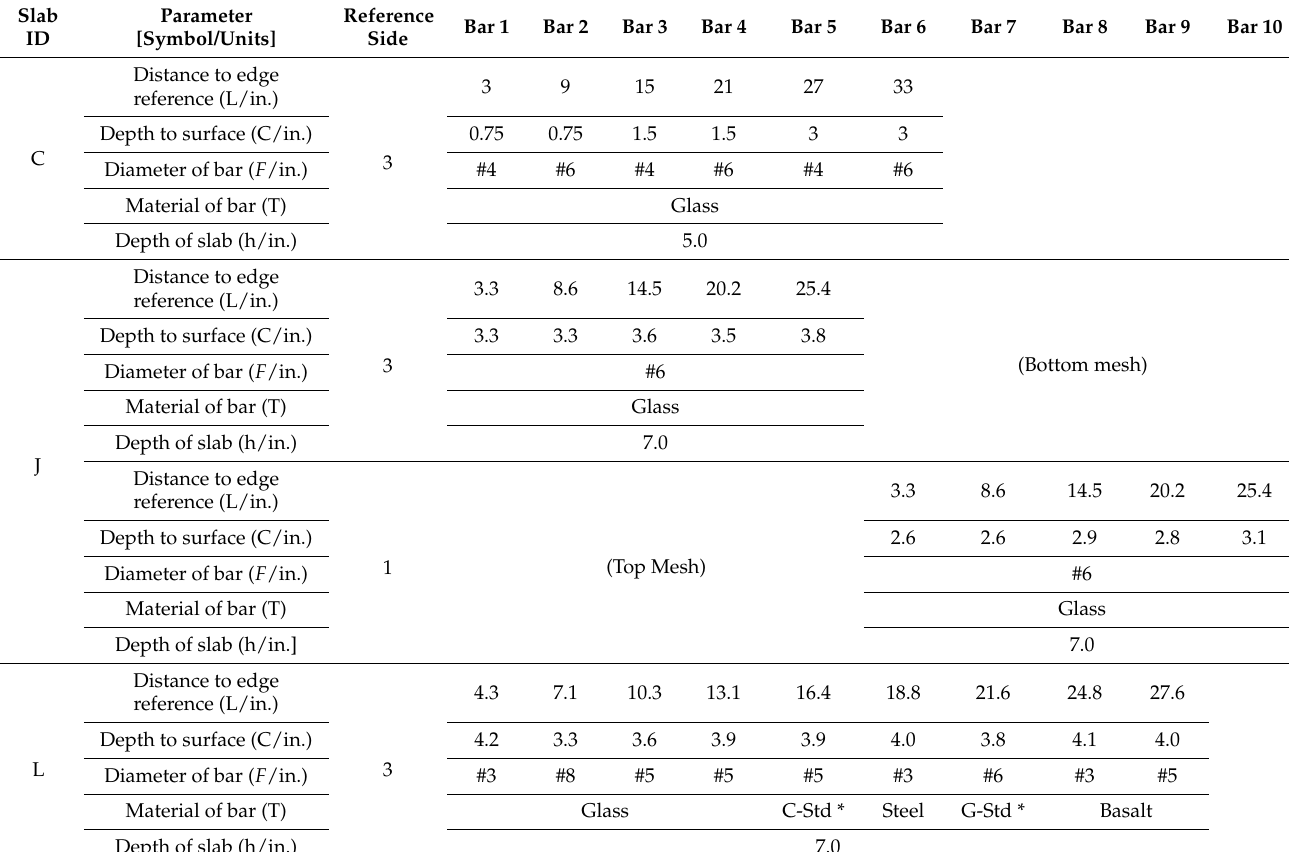
Table 2. Reinforcement/Dimension details of detectability slab